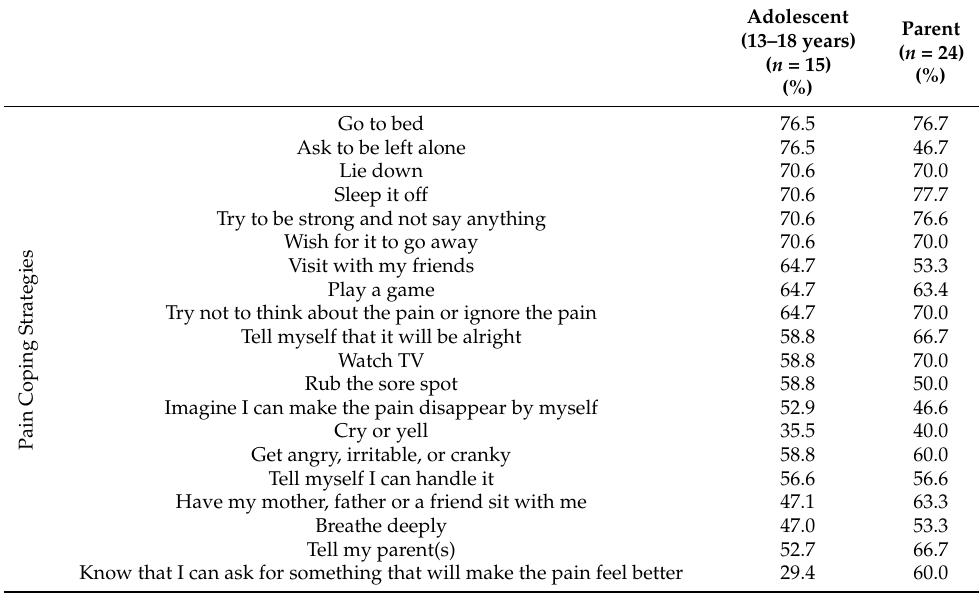
Table 8. Pain coping strategies in adolescents with Tourette Syndrome (TS) and their